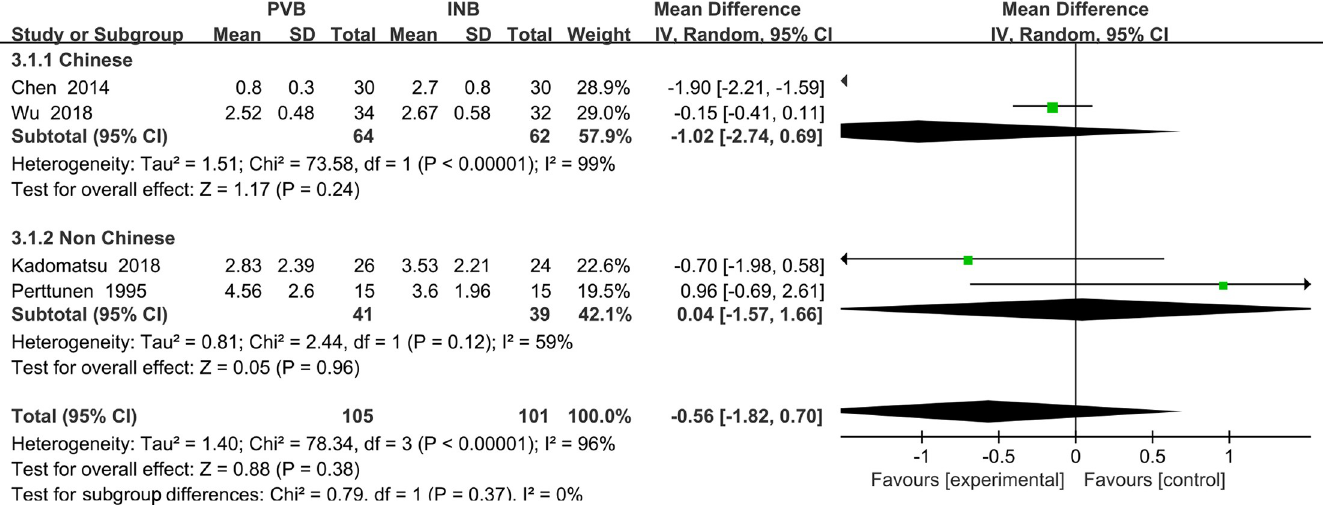
PLOS ONE | https://doi.org/10.1371/journal.pone.0237363 October 5,